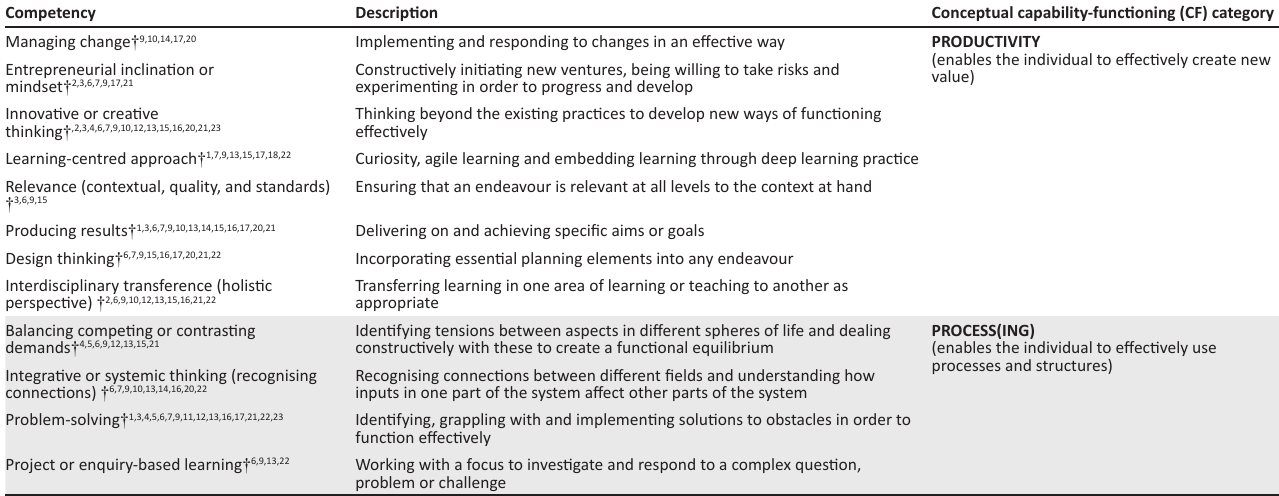
TABLE 1 (Continues...): Synthesis of potential 21st-century competencies.